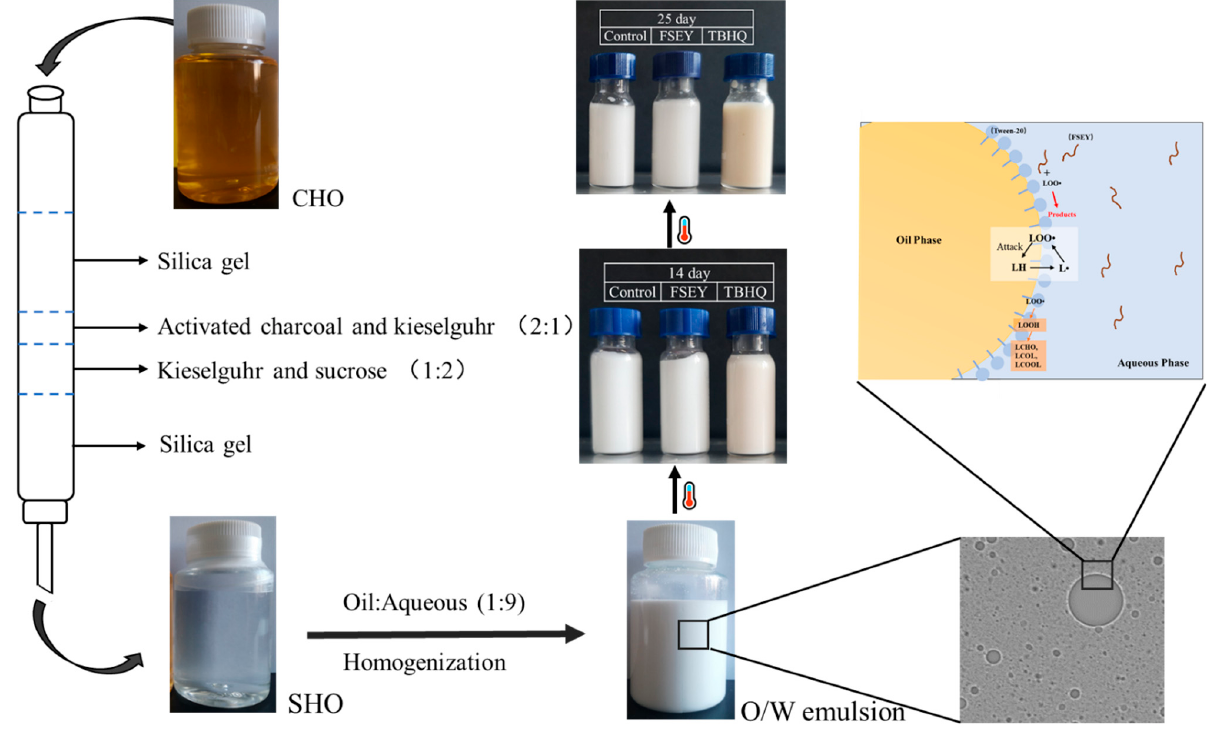
Figure 1. Procedures for preparing purified oil and its emulsion.